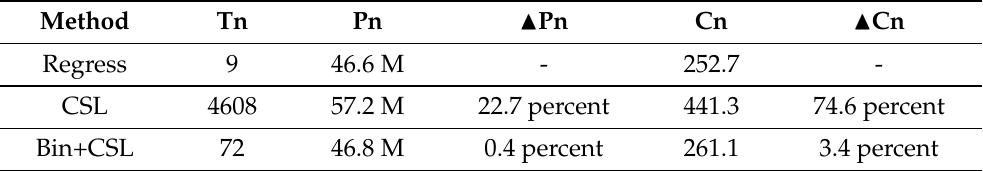
Table 2. Comparison of parameter